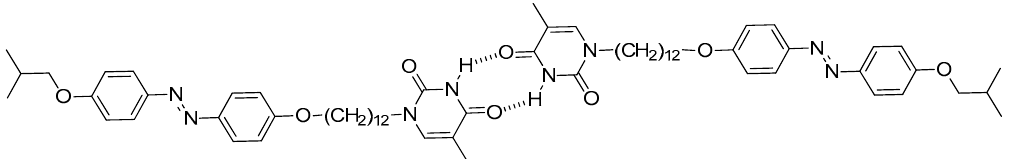
Figure 4. Proposed symmetric dimer formed between tAZOi units, tAZOi-2HB-sym. Dotted lines indicate hydrogen bonding.